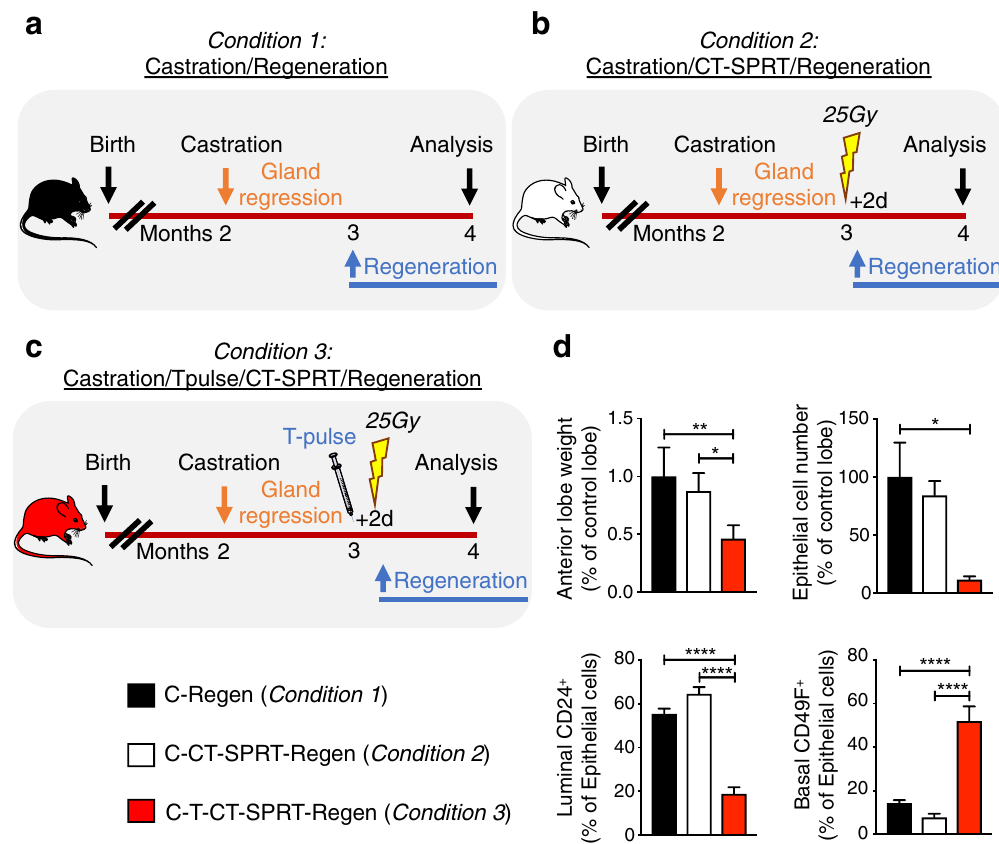
Figure 3. Effect of various CT-SPRT regimen on sustained prostate ablation. Diagrams depicting experimental design to assess the effect of: ( a ) Condition 1, post-castration testosterone-induced prostate regeneration; ( b ) Condition 2, effect of CT-SPRT on the castrate prostate prior to exogenous testosterone-induced regeneration; and ( c ) Condition 3, the effect of short pulse (2 days) of exogenous testosterone prior to CT-SPRT on the castrate prostate, then testosterone-induced regeneration. ( d ) Quantification of post intervention prostate weight (Top Left), epithelial cell number (Top Right), relative luminal epithelial cell (CD24 + ) contribution (Bottom Left), and relative basal epithelial cell (CD49f + ) contribution (Bottom Right). n = 4 to 5 mice per condition. Castration-Regeneration = C-Regen (Condition 1); Castration-CT-SPRT-Regeneration = C-CT-SPRT-Regen (Condition 2); Castration-TestosteronePulse-CT-SPRT-Regeneration = C-T-CT-SPRT-Regen (Condition